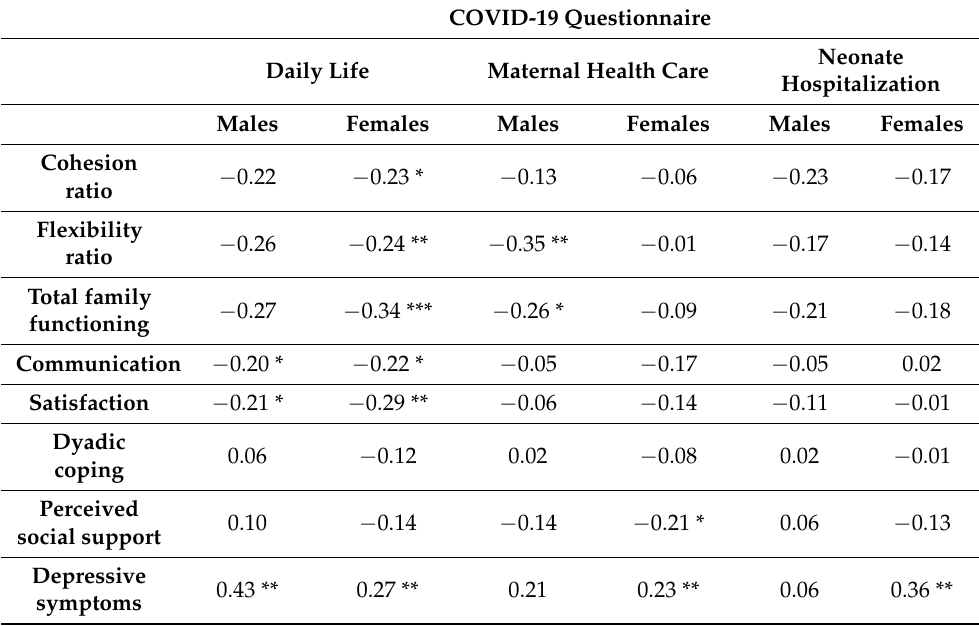
Table 3. Associations between COVID-19-related life changes and family functioning, dyadic coping, perceived social support and postnatal depressive symptoms in males and females. COVID-19